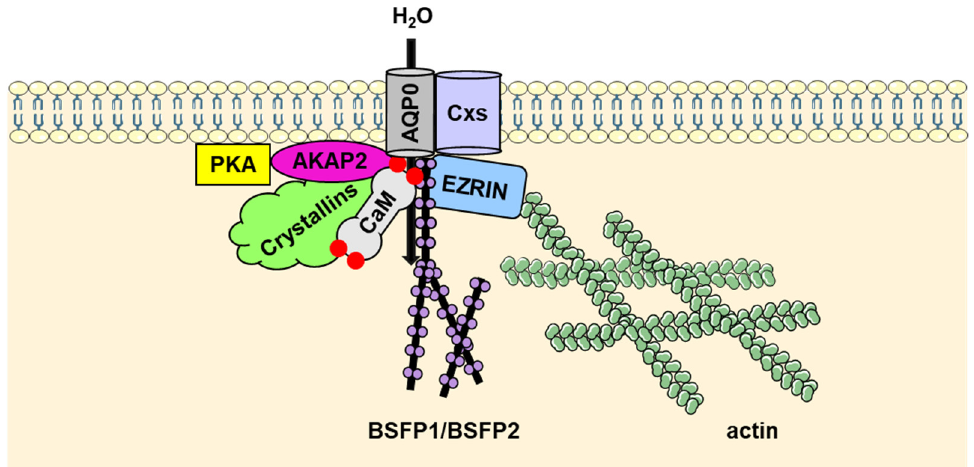
Figure 2. Roles of the protein–protein interactions involving AQP0. In the developing lens fiber cell, AQP0 and Cxs join to modulate cell–cell adhesion. AQP0 interacts with ezrin to directly link the plasma membrane with the actin cytoskeleton. Lens-specific beaded intermediate filaments, BFSP1 and BFSP2, also interact with AQP0 to link the plasma membrane to cytoskeletal structures. BSFP1 fragments can reduce AQP0 water permeability. AQP0 interacts with CaM to regulate water permeability. Interactions with AKAP2 modulate AQP0 phosphorylation, which affects CaM binding and water permeability. Interactions with abundant crystallin proteins occur, but with unknown functional consequences. AKAP2: A-kinase anchoring protein 2; BFSP1: beaded filament structural protein 1 (also called filensin); BFSP2: beaded filament structural protein 2 (also called 49 kDa Cytoskeletal Protein (CP49) or phakinin); CaM: calmodulin; Cxs: connexins; PKA: protein kinase A.